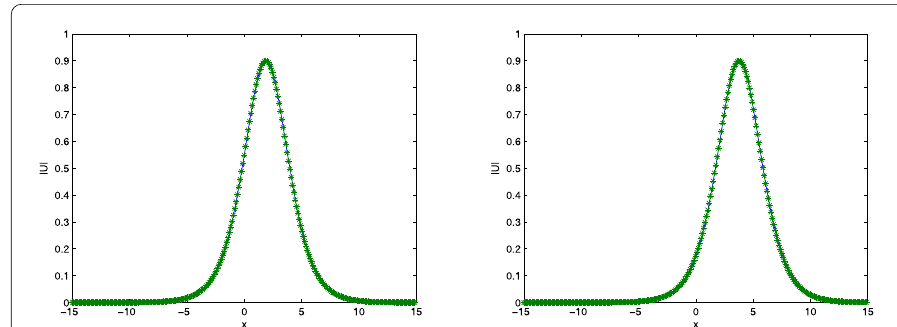
Figure 2 The wave forms of the numerical solutions for t = 3